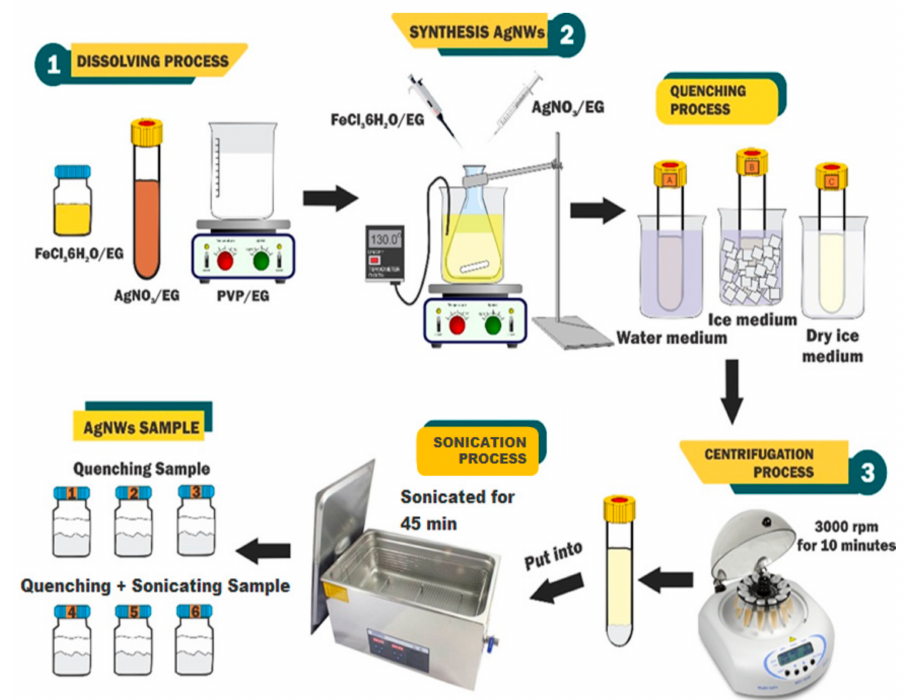
Figure 6. Synthesis of silver nanowires by polyol